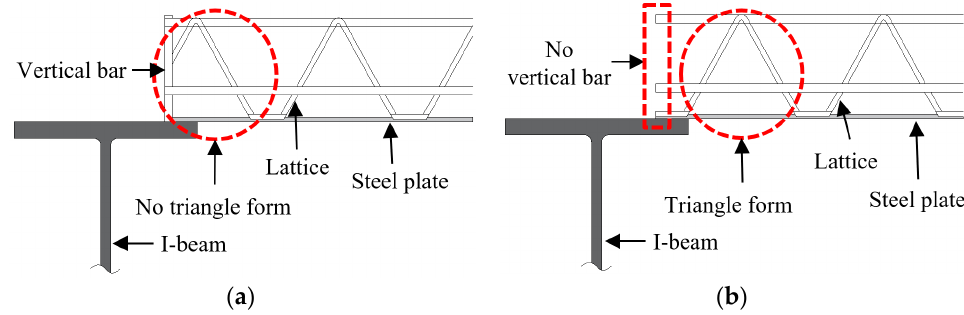
Figure 1. End details of the wire-integrated deck plate. ( a ) Conventional end details. ( b ) Proposed end details.